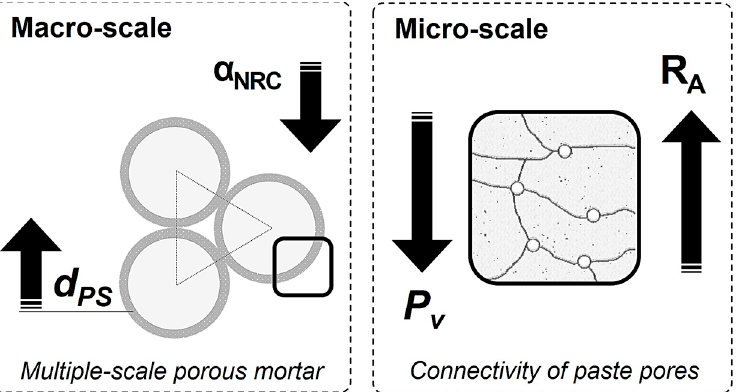
Figure 10. Semi-quantitative model for the acoustic performance of multiscale porous lime-cement mortars.